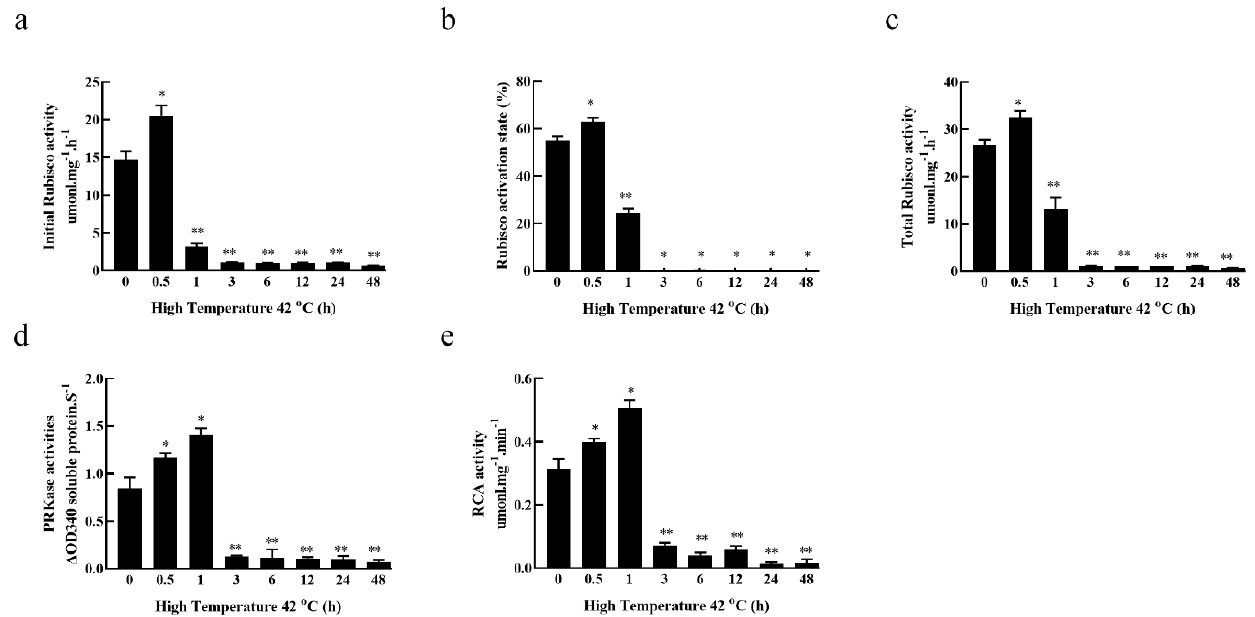
Figure 2. Effects of high-temperature stress on carbon assimilation enzyme activity in the leaves of fragrant woodfern at different times. Effects of high-temperature exposure on total Rubisco activity ( a ), initial Rubisco activity ( b ), Rubisco activation state ( c ), RCA activity ( d ) and PRK activity ( e ) in the leaves of fragrant woodfern at different times. Each bar in the graph corresponds to the mean value ± SD of three independent replicates. * p < 0.05; ** p < 0.01.